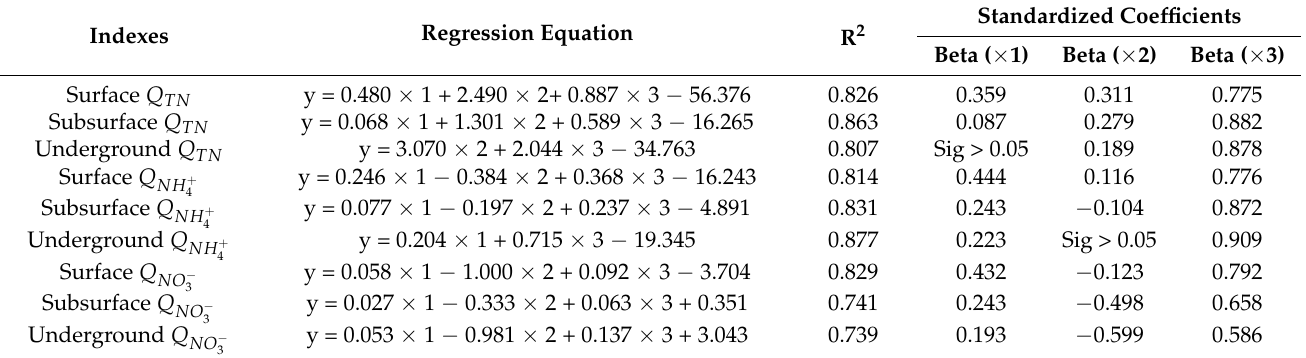
Table 9. Factors affect nitrogen loss of rainfall intensity ( × 1), slope angle ( × 2), and rainfall duration ( ×